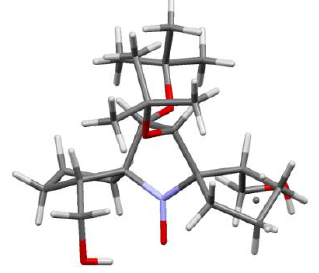
Figure 9. Crystal structure of SNR 221 .